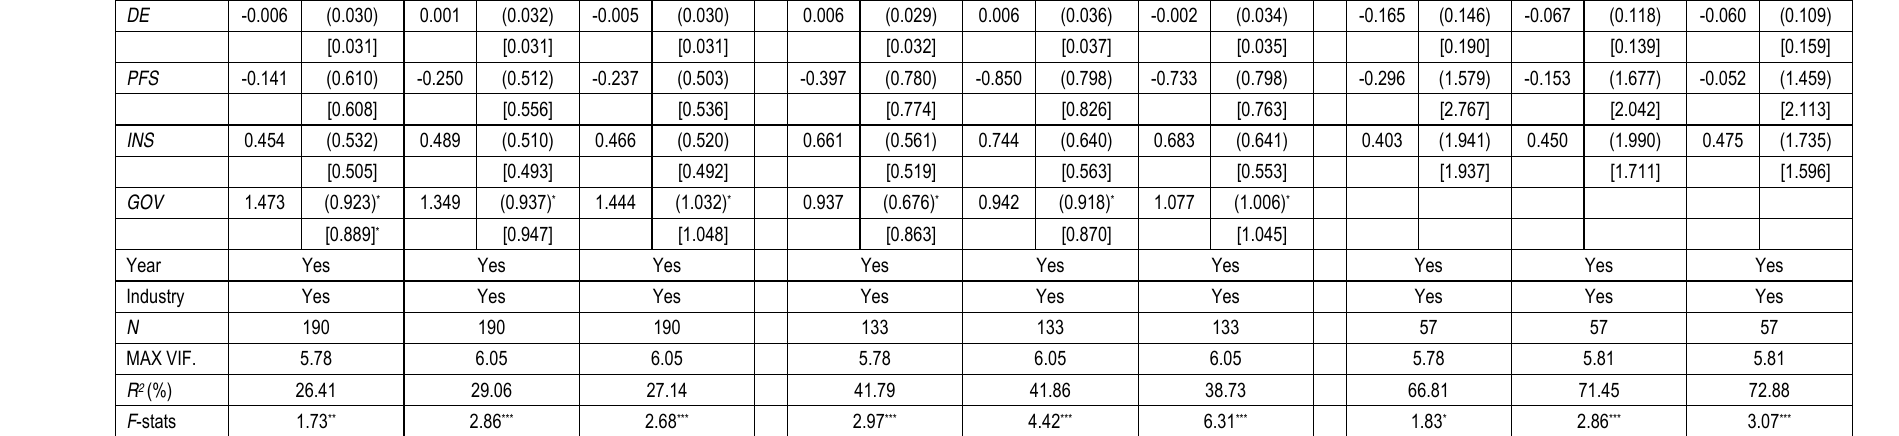
Table 7. (cont.). OLS Estimates-Robust and bootstrap Standard Errors (BHARS)